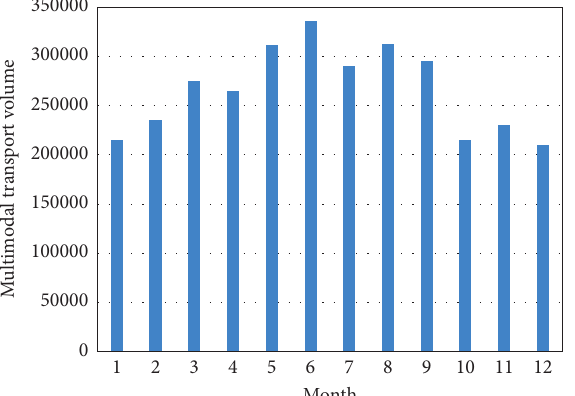
Figure 5: Distribution of multimodal transport volume in 2020.